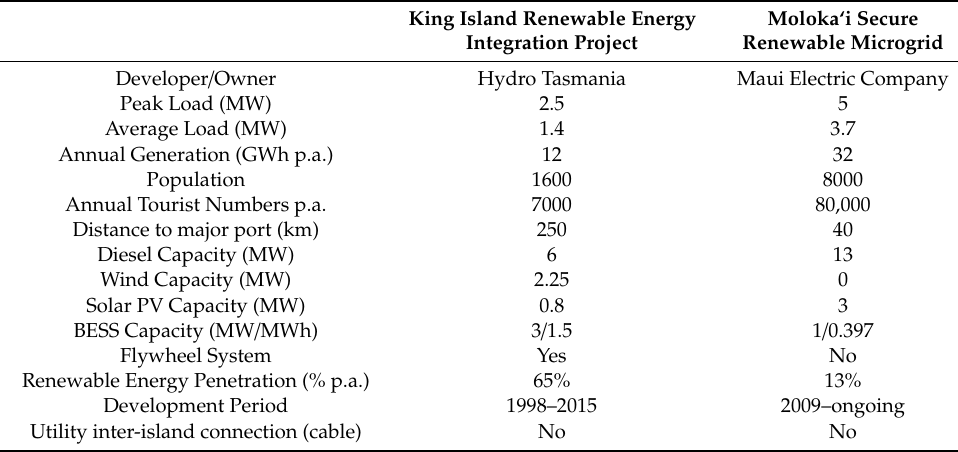
Table 2. Island power systems case study